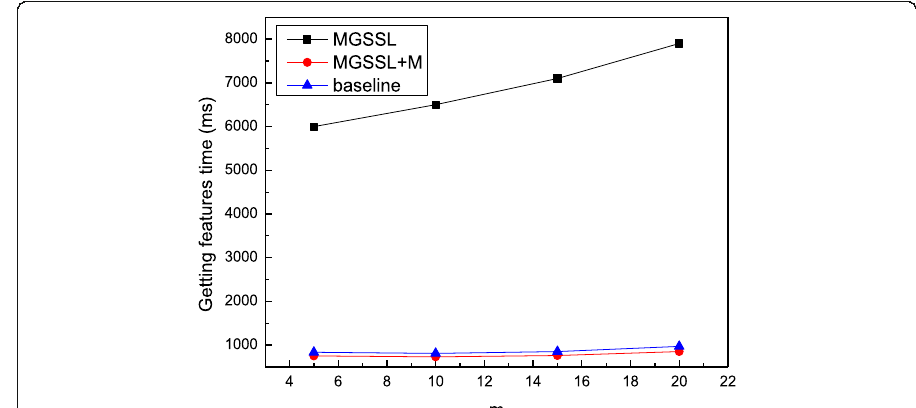
Fig. 3 Mining times of the optimal feature subset on 40 multi-dataset with label of MR-MGSSL , MGSSL+M, and baseline